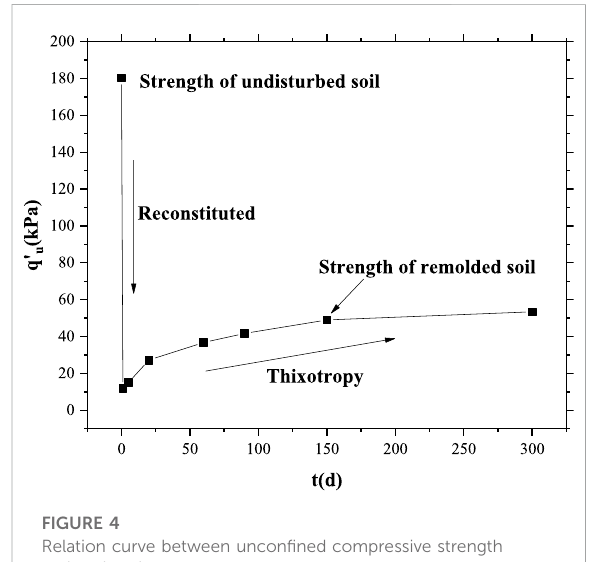
FIGURE 5 Correlation betweenthethixotropicstrengthratioandcuring